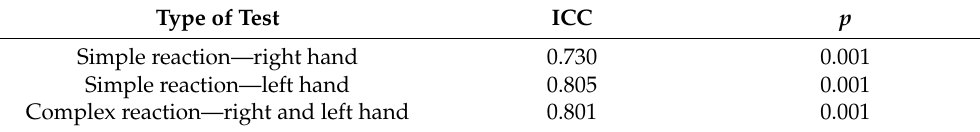
Table 2. Intraclass correlation coefficients (ICC) for VR-implemented simple and complex reaction tests.